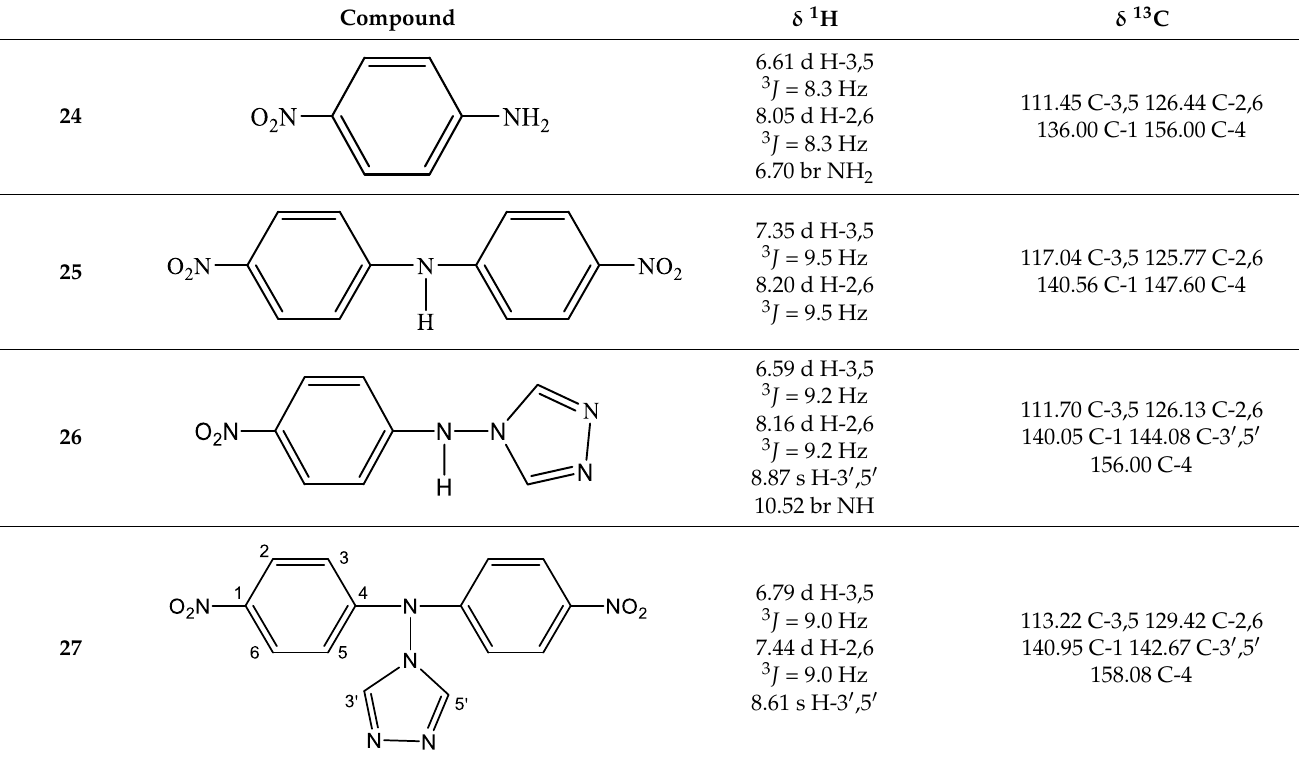
Scheme 14. Products of the interaction of nitrobenzene ( 23 ) with 4-amino-1,2,4-triazole ( 19 ) in a superbasic medium. Table 2. 1 H and 13 C NMR chemical shifts of nitrobenzene amination products (ppm) (DMSO- d 6 ). Compound δ 1 H δ 13 C